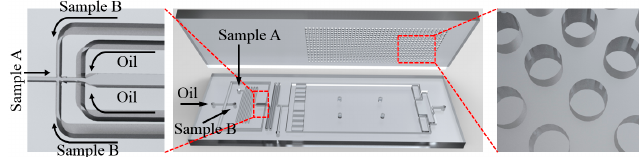
Figure 2. CAD rendering of the Floating Droplet Array. The top layer of the FDA device contains the droplet-trapping microwells while the bottom layer contains the droplet generation and chamber modules ( Middle ). Droplets are generated using a flow-focusing structure ( Left ) and trapped into circular microwells ( Right ). Device geometries were exaggerated in the rendering for visualization purposes.